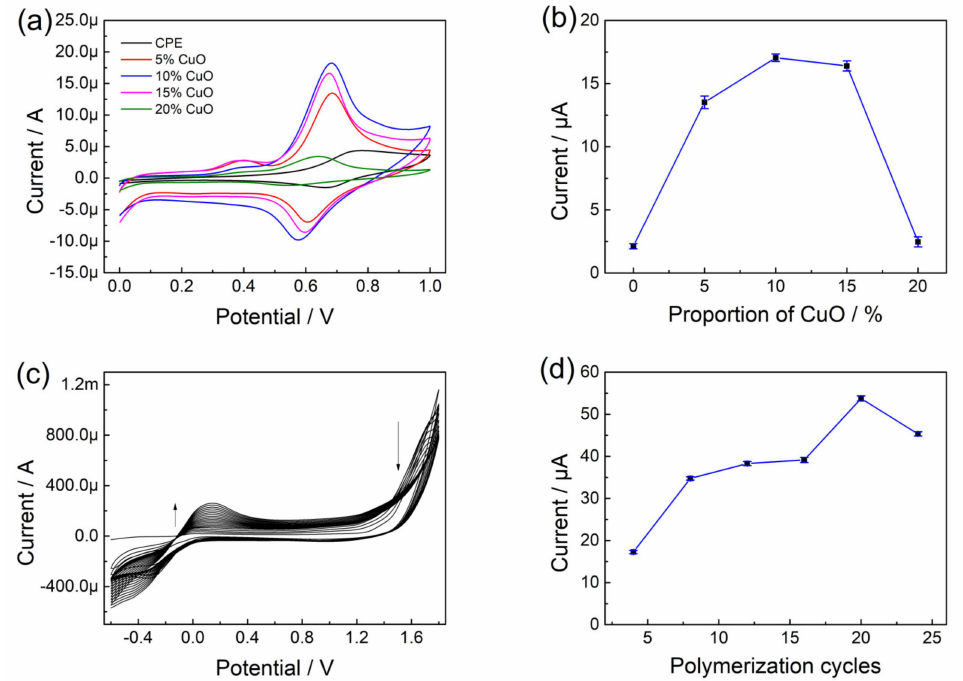
Figure 2. ( a ) CV of CuO/CPE prepared by different proportions of CuO nanoparticles in olivetol solution; ( b ) Effect of proportion of CuO nanoparticles on peak currents of electrodes in olivetol; ( c ) CV of preparation of p-L-serine/CuO/CPE; ( d ) Effect of polymerization cycles on peak currents of electrodes in